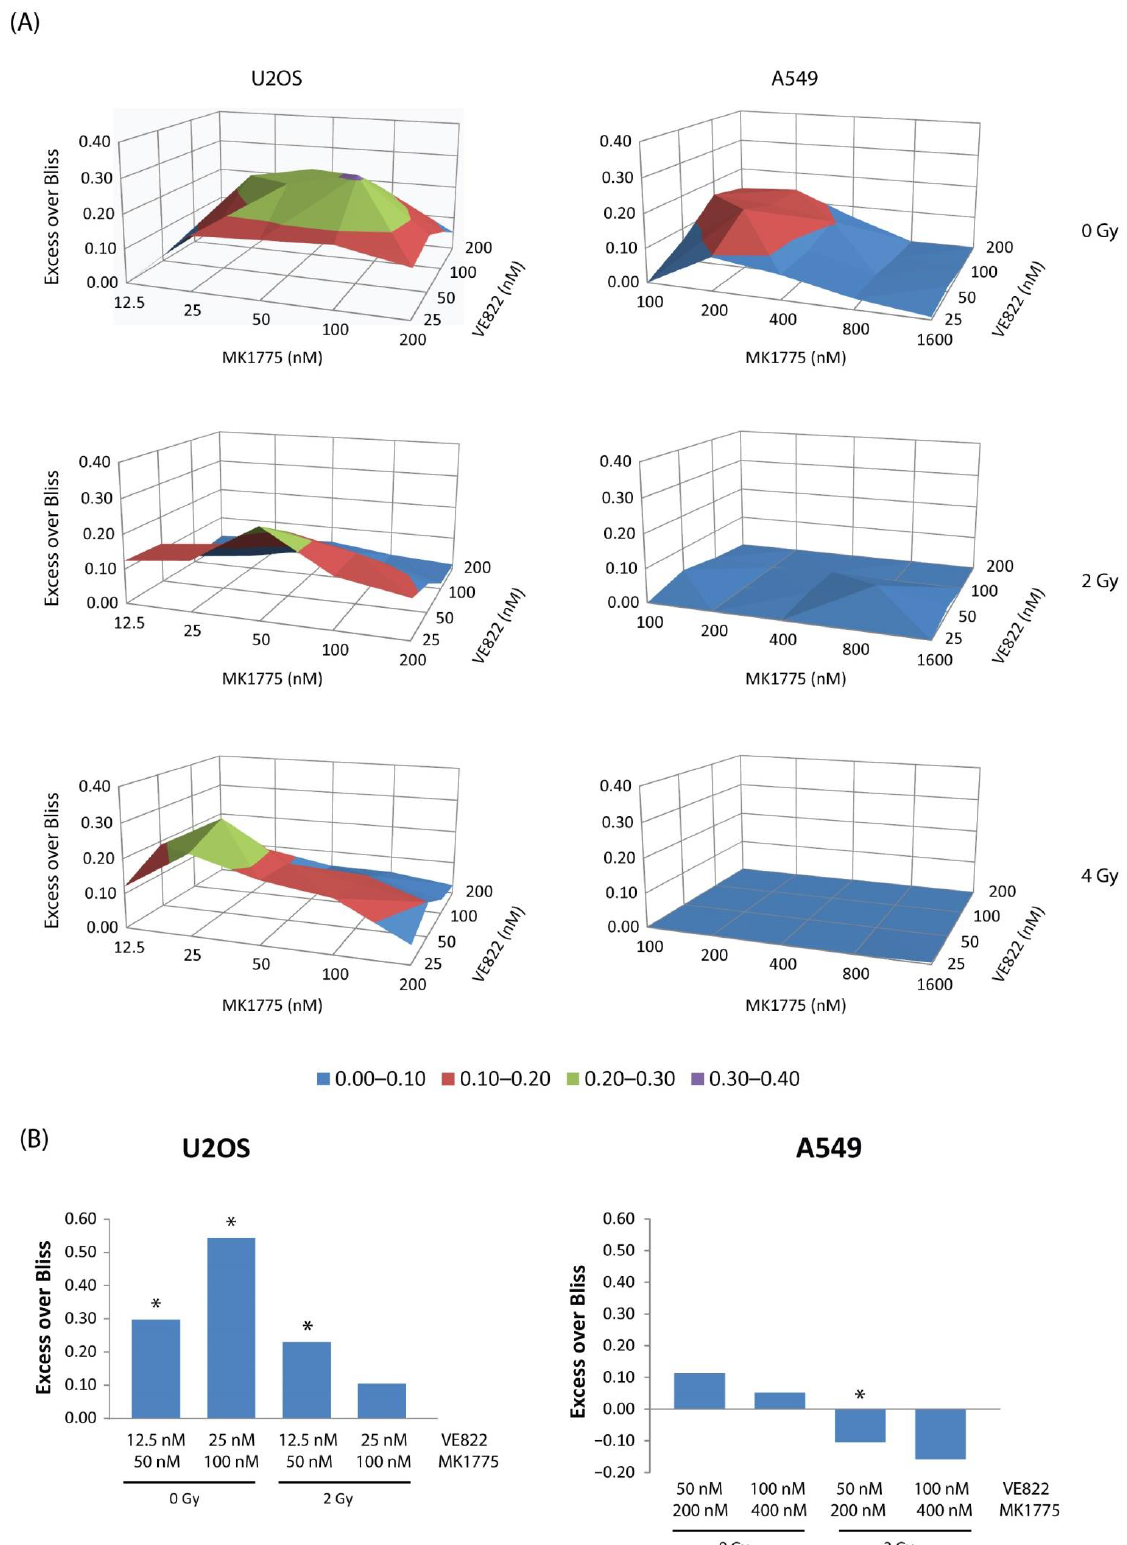
Figure 6. Synergy between MK1775 and VE822 is weakened when combined with radiation. ( A ) U2OS and A549 cells were seeded in 96-well plates pre-printed with a matrix of different concentrations of VE822 and MK1775 alone and in combination and exposed to X-ray radiation at doses of 2 and 4 Gy or left unexposed. Drugs were washed out 48 h